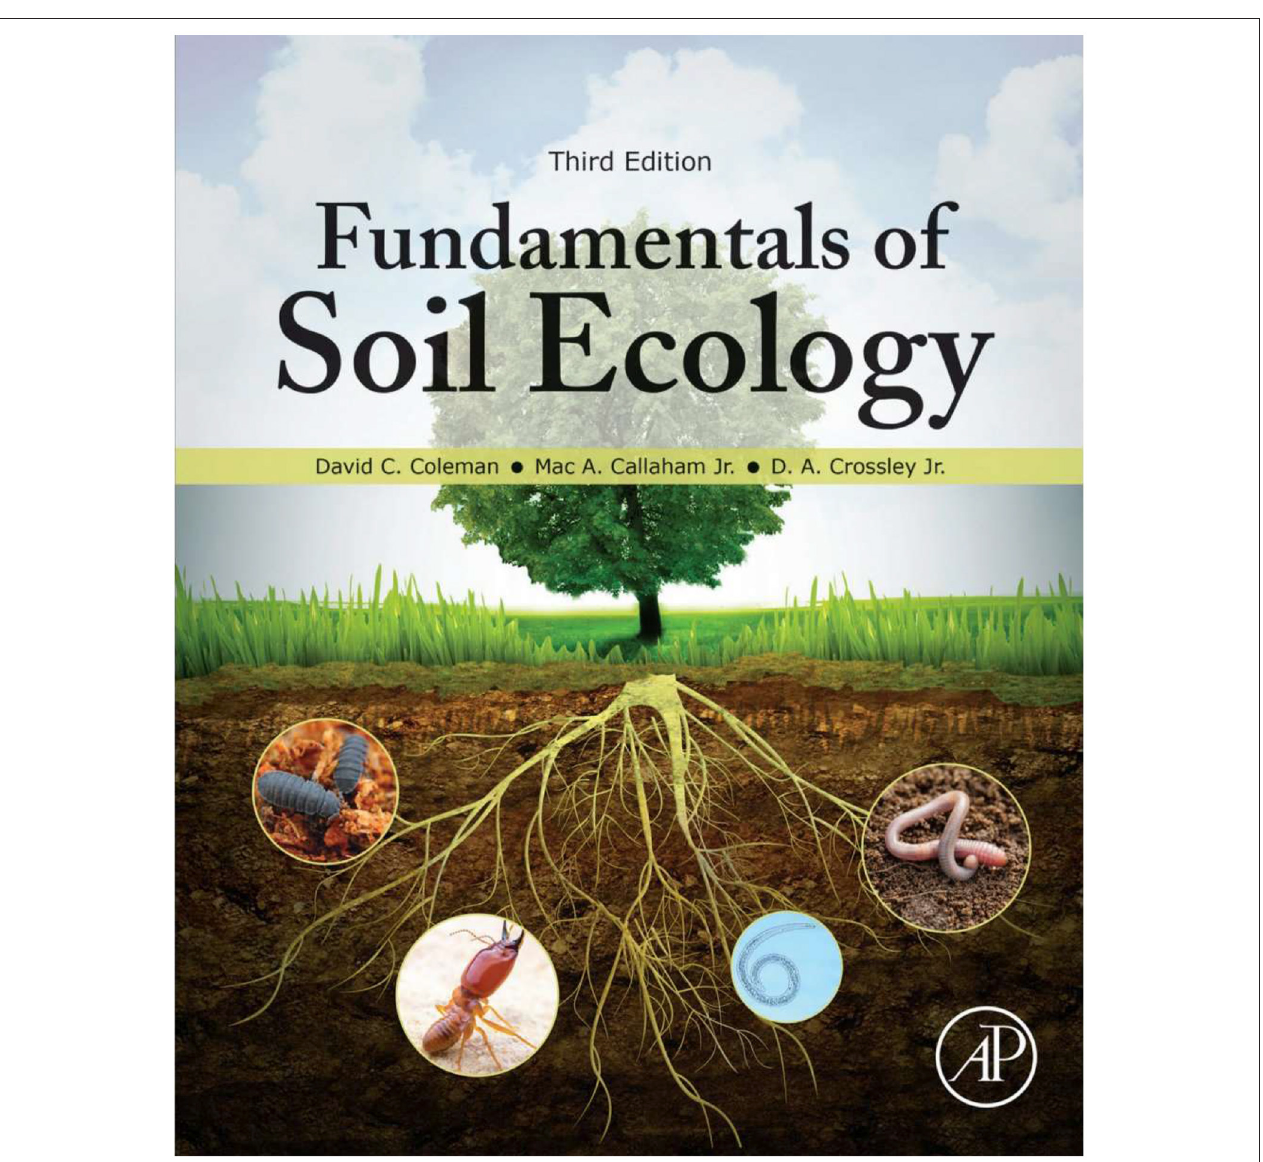
FIGURE 1 | Book cover of Fundamentals of Soil Ecology (Reprinted with permission of Elsevier, holder of copyright).